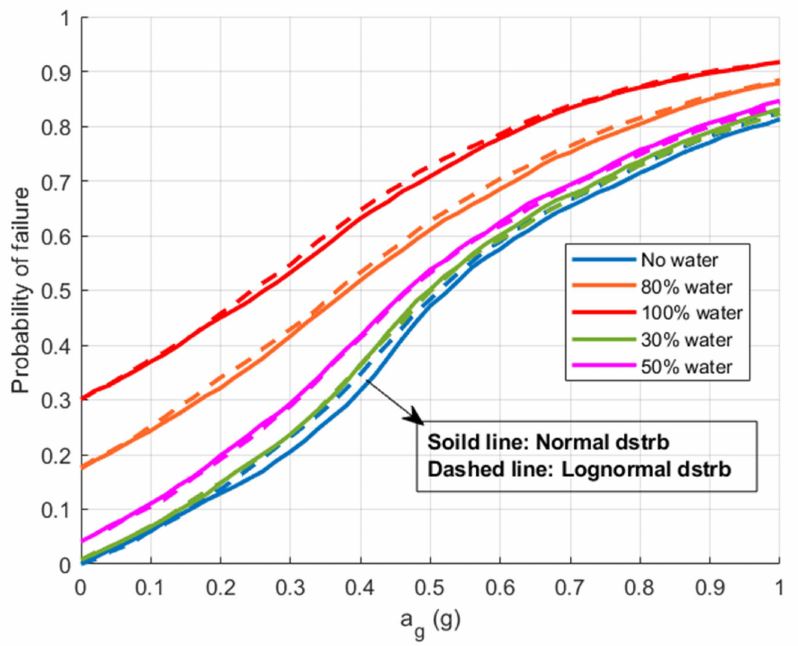
Figure 12. Fragility curves of rock slope wedge sliding for the island of Thasos, in terms of peak ground acceleration (a g ) and percentage of fill of the discontinuities with water, for slope dip direction between 220 ◦ and 248 ◦